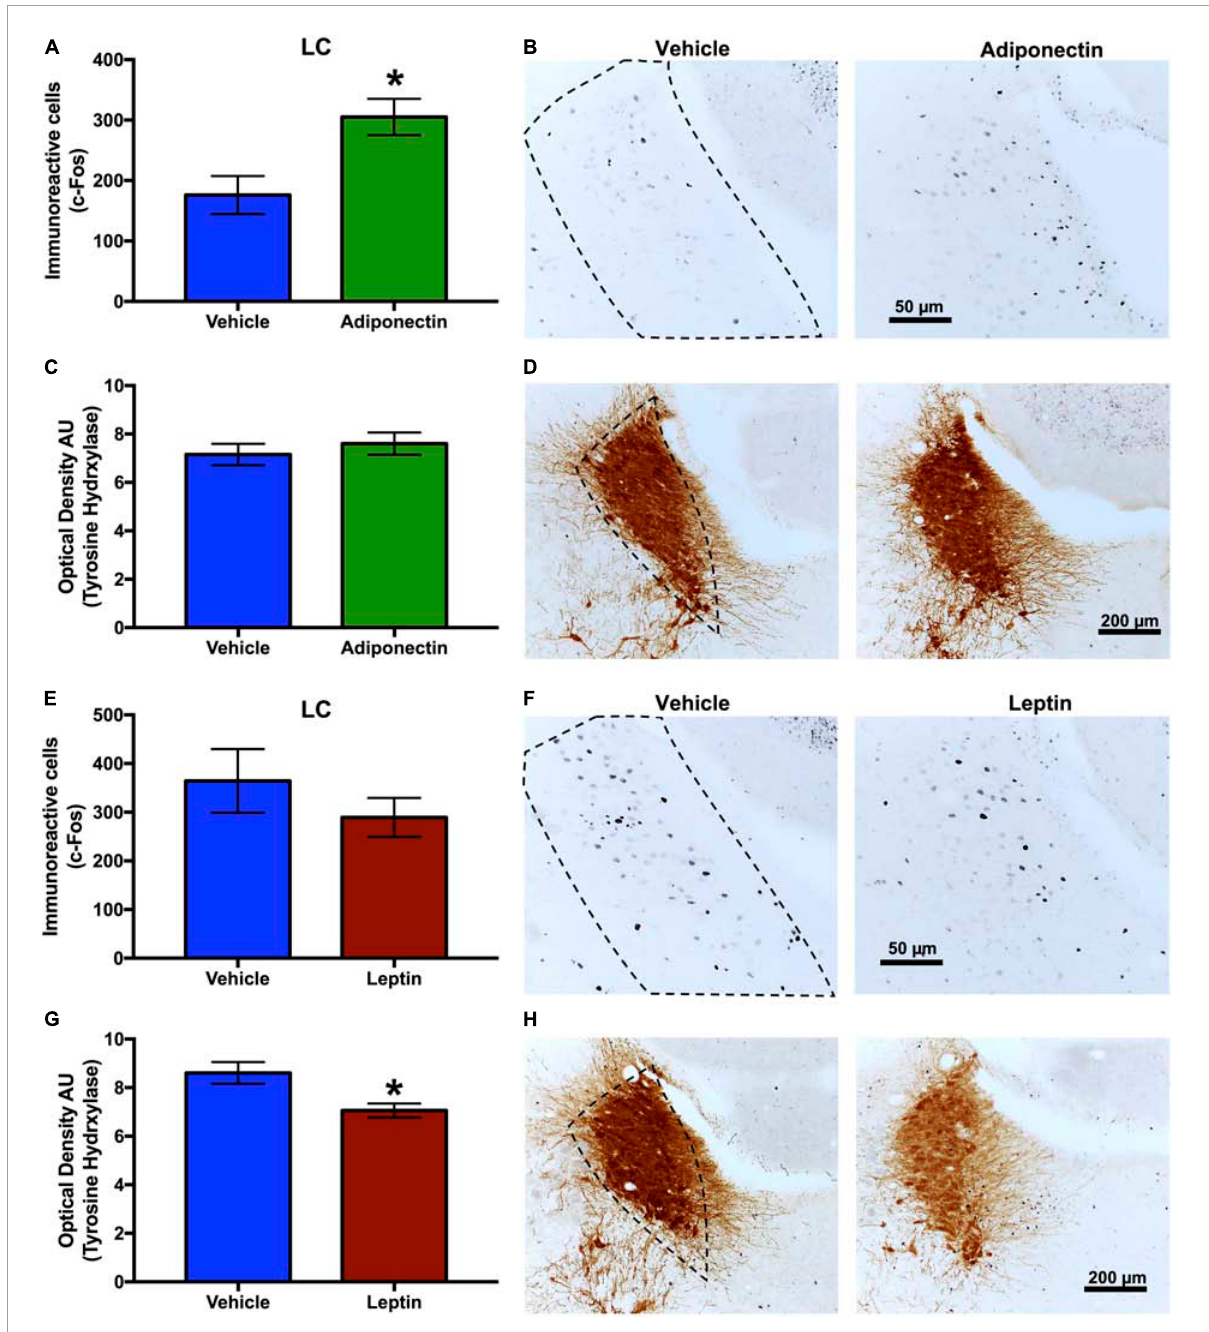
FIGURE7 c-Fos and TH immunoreactivity in the LC after adipokines or vehicle administration. Immunoreactive cells to c-Fos in LC 2 h after (A,B) adiponectin or (E,F) leptin administration. Immunoreactive cells to TH in LC 2 h after (C,D) adiponectin or (G,H) leptin administration. Representative images (right columns, dashed lines border the nucleus area). Adipokine vs. vehicle * P < 0.05. LC, locus